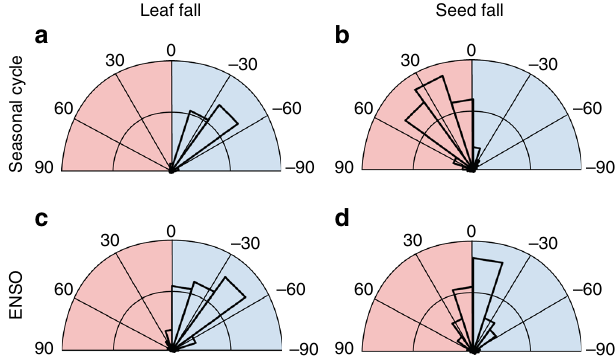
Fig. 4 Temporal lags between climate and phenology. Phase-angle histograms for leaf and seed fall with soil water de fi cit at seasonal cycles (12 months; a , b ) and periods of 2 – 7 years, corresponding to ENSO cycles ( c , d ). Phase angles were calculated for areas inside the cone of in fl uence and for coherence >0.5 in Fig. 3. An angle of 30° corresponds to ~1 month for the seasonal cycle and 2 – 7 months for the ENSO cycle. Angles in the blue (red) shaded areas indicate that plant phenology leads (lags)